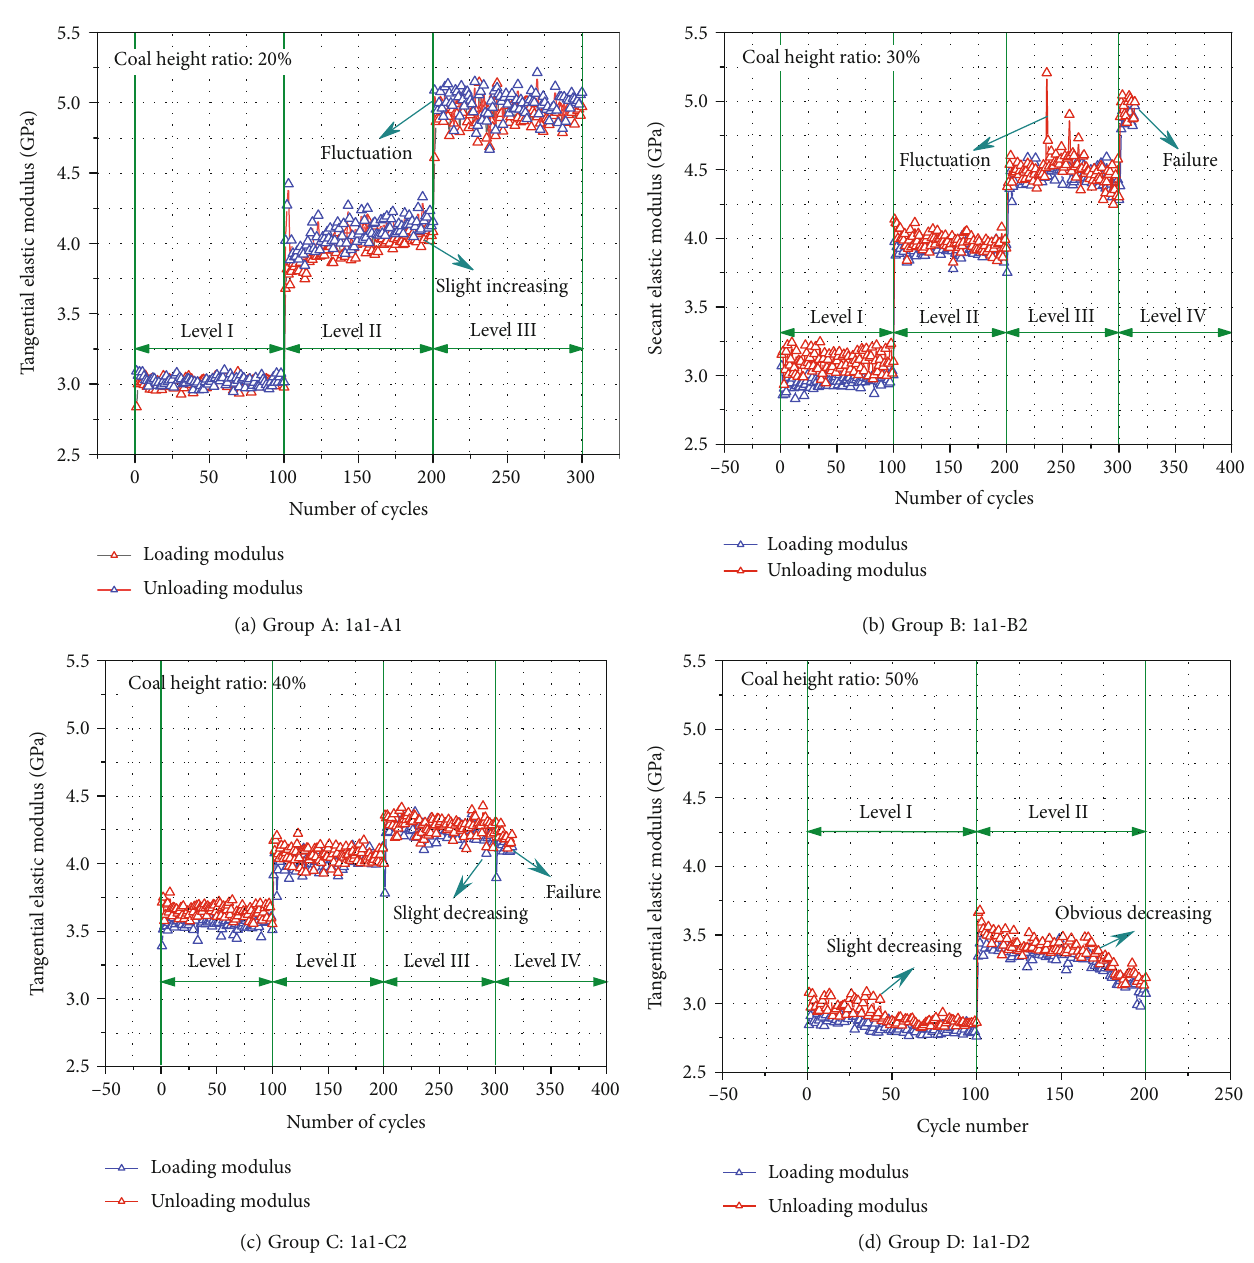
Figure 7: Evolution laws of loading and unloading elastic modulus of